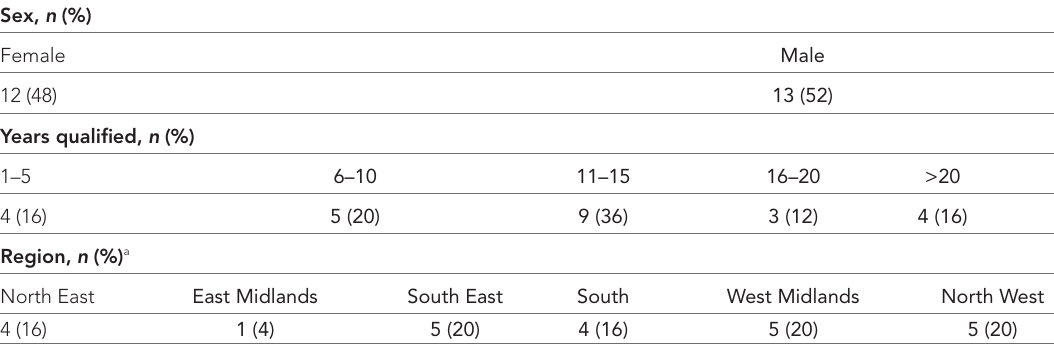
Table 2 Summary characteristics of